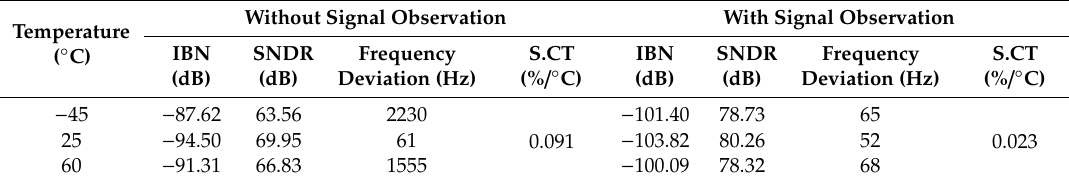
Table 2. Performances at different temperature points with an 11 kHz sinusoidal input signal.